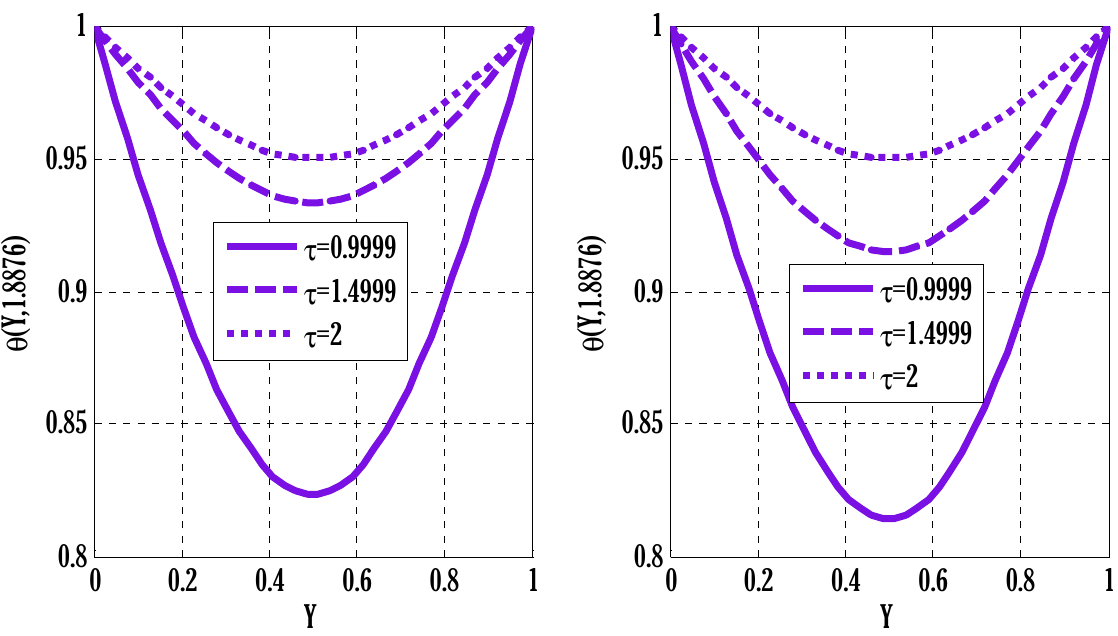
Figure 6. Contours of flow’s temperature at different times ( a ) τ = 0.9999, ( b ) τ = 1.4999, ( c ) τ = 2 using N τ = 8000, N Y = 40, N Z = 900, Pe 1 = 5.